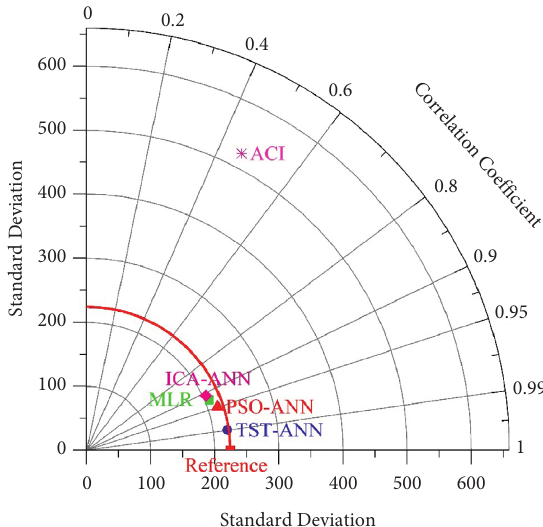
Figure 13: Taylor diagram visualization of model performance, in terms of shear strength.